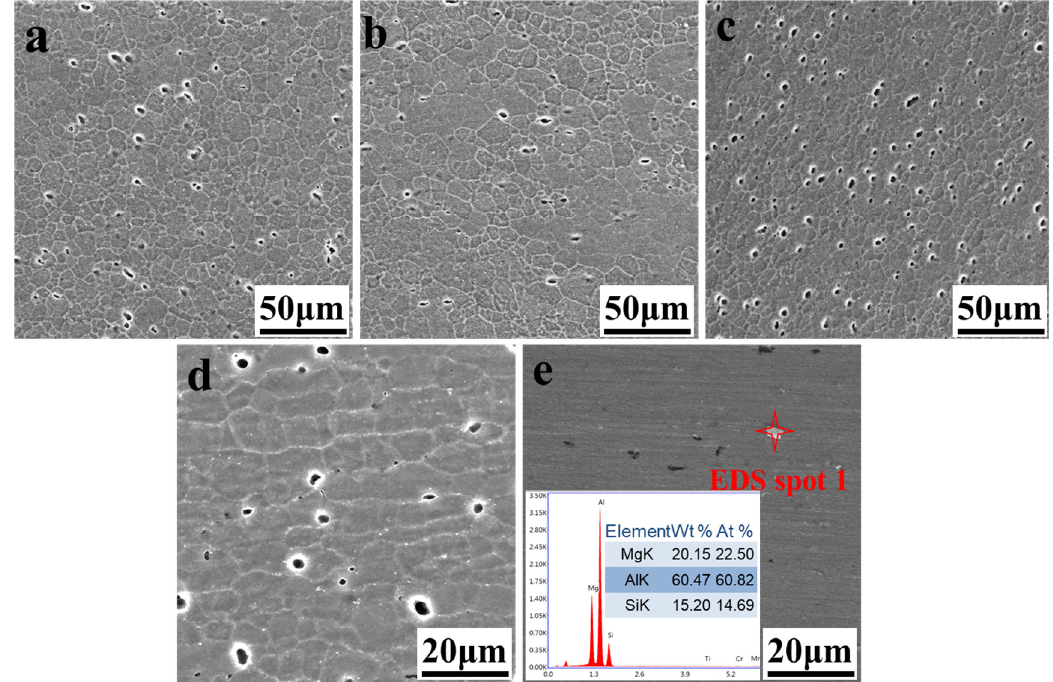
Figure 7. Microstructure under scanning electron microscope (SEM) at the rotation speed of 400 rpm and welding speed of 350 mm/min in the section of: ( a ) NZ; ( b ) TMAZ on the AS; ( c ) TMAZ on the RS; ( d ) HAZ and ( e ) energy-dispersive spectroscopy (EDS) result of the precipitated particles.